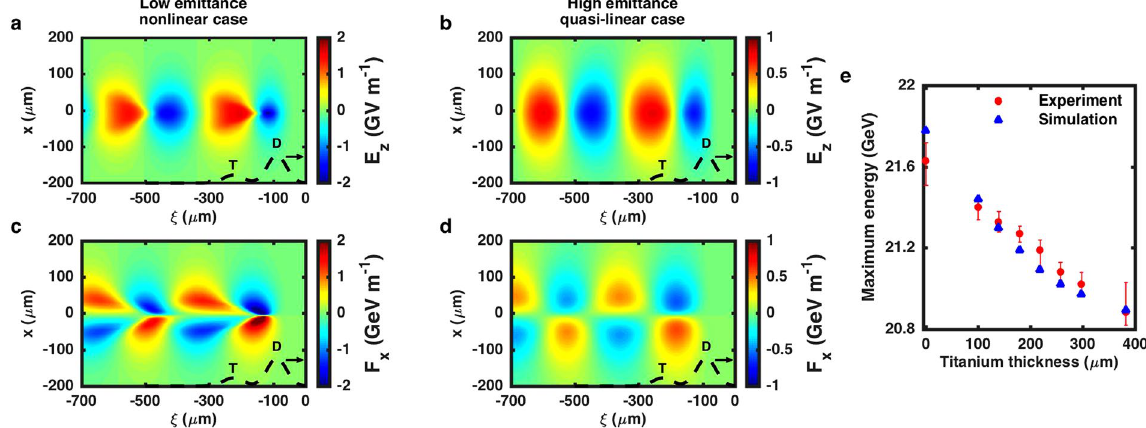
Figure 4. Simulated nonlinear and quasi-linear wakefields, and maximum energy. ( a , b ) Longitudinal electric field E z in the plasma wake for the low emittance case (no titanium) with x and y emittances of 100 μ m × 10 μ m ( a ) and for the high emittance case (297 μ m of titanium) with x and y emittances of 270 μ m × 60 μ m ( b ). ( c , d ) Transverse force F x  e(E x − cB y ) experienced by the positrons in the plasma wake for the low emittance case ( c ) and for the high emittance case ( d ). e , Maximum energy (defined as the energy where the accelerated spectrum crosses the 10 pC GeV − 1 threshold) as a function of the titanium thickness, in the experiment and in simulations. As the most important error on the maximum energy arises from the sensitivity to the threshold, the error bars depict the effect of multiplying and dividing the threshold by 1.5. In ( a – d) x is the transverse coordinate, ξ = z − ct is the dimension parallel to motion, and the bunches are propagating to the right (direction indicated by the black arrows). Black dashed lines represent the current profile and depict the positions of the drive (D) and trailing (T) bunches in the